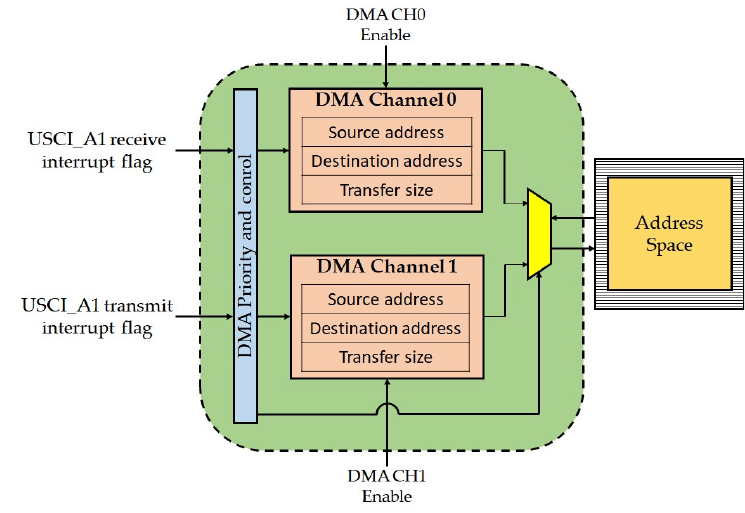
Figure 9. DMA module diagram summary. The DMA module receives the data by serial. This data are stored in a vector (Address space). Moreover, the data can be used in parallel in the microcontroller CPU operations.